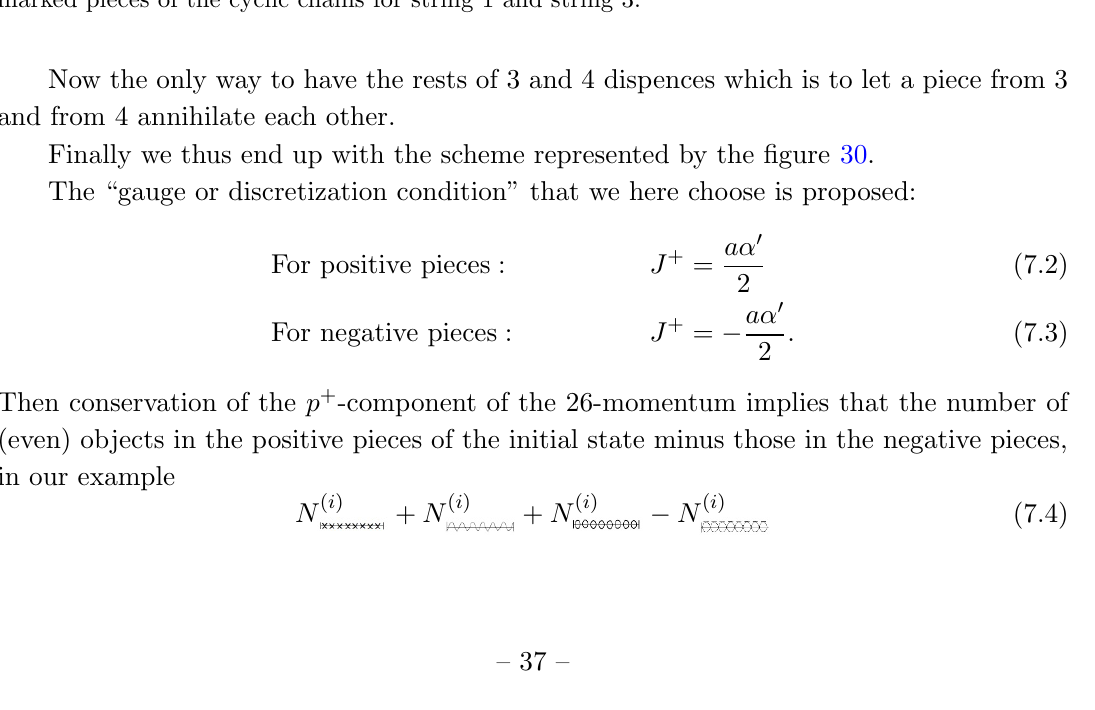
Figure 30 . The analogue of (cid:12)gure 19 but now negative P + (and thus energy) on the with { ‘s marked pieces of the cyclic chains for string 1 and string